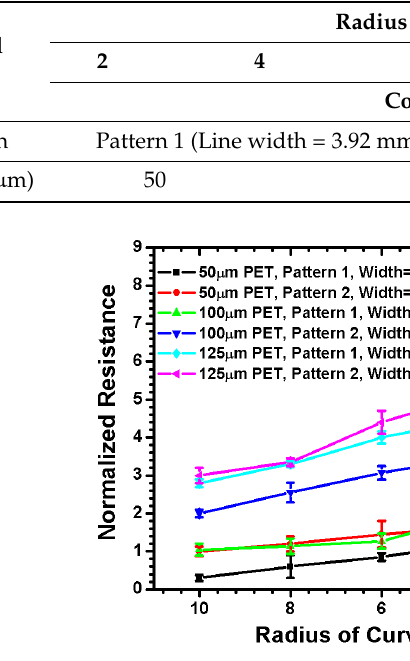
Figure 6. Normalized electrical resistance of patterned ITO/PET film with different PET substrate thickness when various bending radius of curvature are applied.